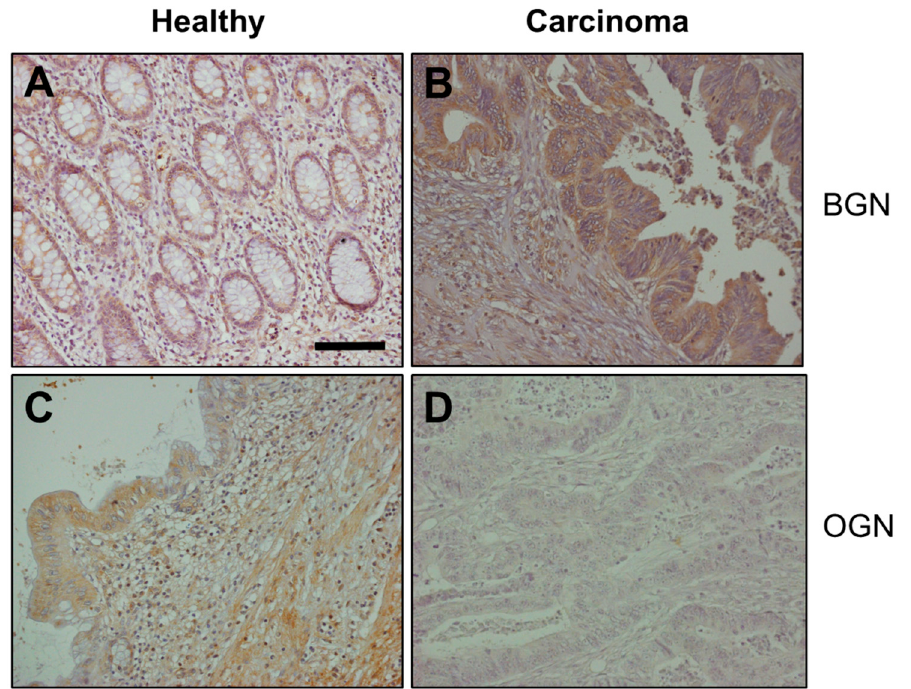
Figure 2. Immunolocalization of SLRPs with altered expression in RSCCs. ( A , B ) Histological localization of BGN expression: ( A ) Normal mucosa showing weak staining; ( B ) Tumor tissue, where BGN appears overexpressed in comparison with the normal mucosa; magnification 100×. ( C , D ) Histological localization of OGN expression: ( C ) Normal mucosa, showing a moderate-intense expression of OGN in the absorptive cells of the colon and in the stroma; ( D ) Tumor tissue, where expression was not detected; magnification 200 × , scale bar: 100 µ